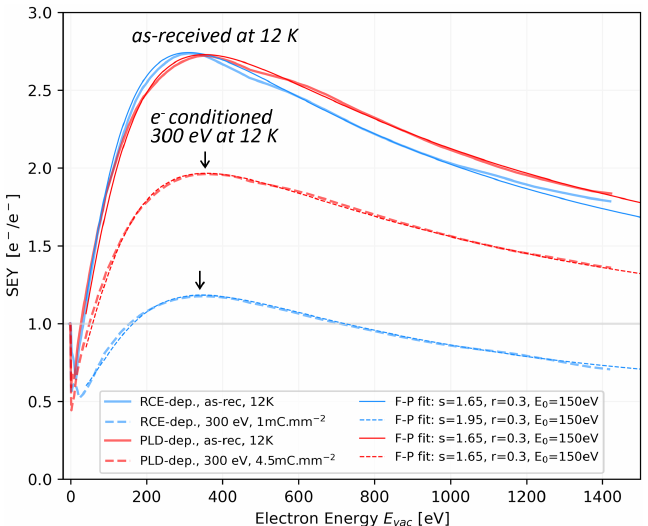
Figure 3. SEY energy dependence of REBCO samples held at 12K measured in as–received and electron–conditioned states using 300 eV electrons at a few mC · mm − 2 doses, as indicated in the legend. The measured data points (not shown) are smoothed with a Savitzky–Golay filter [42] and plotted as a thick line, while the Furman–Pivi approximation [43] is the thin